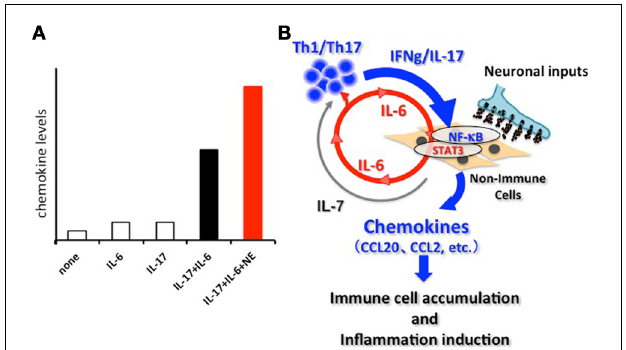
FIGURE 1 | The inflammation amplifier. (A) Image of the activation of the inflammation amplifier in the presence and absence of NE. A combination of IL-17 and IL-6 causes a synergistic effect on the induction of inflammation-amplifier target chemokines such as CCL20 in non-immune cells including fibroblasts, endothelial cells, and certain synovial cells. NE further enhances the chemokine production. Other neurotransmitters can also influence activation of the inflammation amplifier. See Arima et al. (2012) for the original data. (B) The synergistic effect seen in (A) requires the concomitant activation of two transcriptions factors, NF-kB and STAT3. In the case of autoimmune diseases, Th-17 derived IL-17 induces an initially low amount of IL-6 from non-immune cells via NF- κ B activation. Secreted IL-6 together with IL-17 forms a positive feedback loop to produce excessive expression of the target genes including many inflammatory chemokines such as CCL20, CCL2, etc. Consequently, various immune cells are recruited at the region around the target cells via chemokine expression, and inflammation takes place. Persistent activation of the inflammation amplifier, as is the case in F759 mice, drives chronic inflammation. IL-7, a target of the amplifier and derived from non-immune cells, fuels the proliferation, and survival of Th17 cells. The activation of the inflammation amplifier can be modulated by regional neural